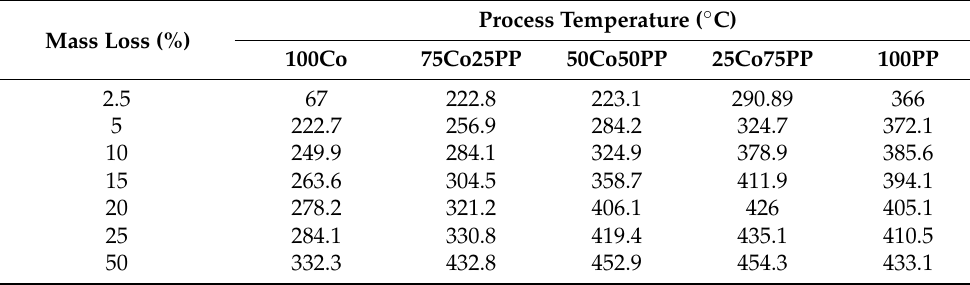
Table 3. Degradation temperature ( ◦ C) and mass loss of biocomposite materials.